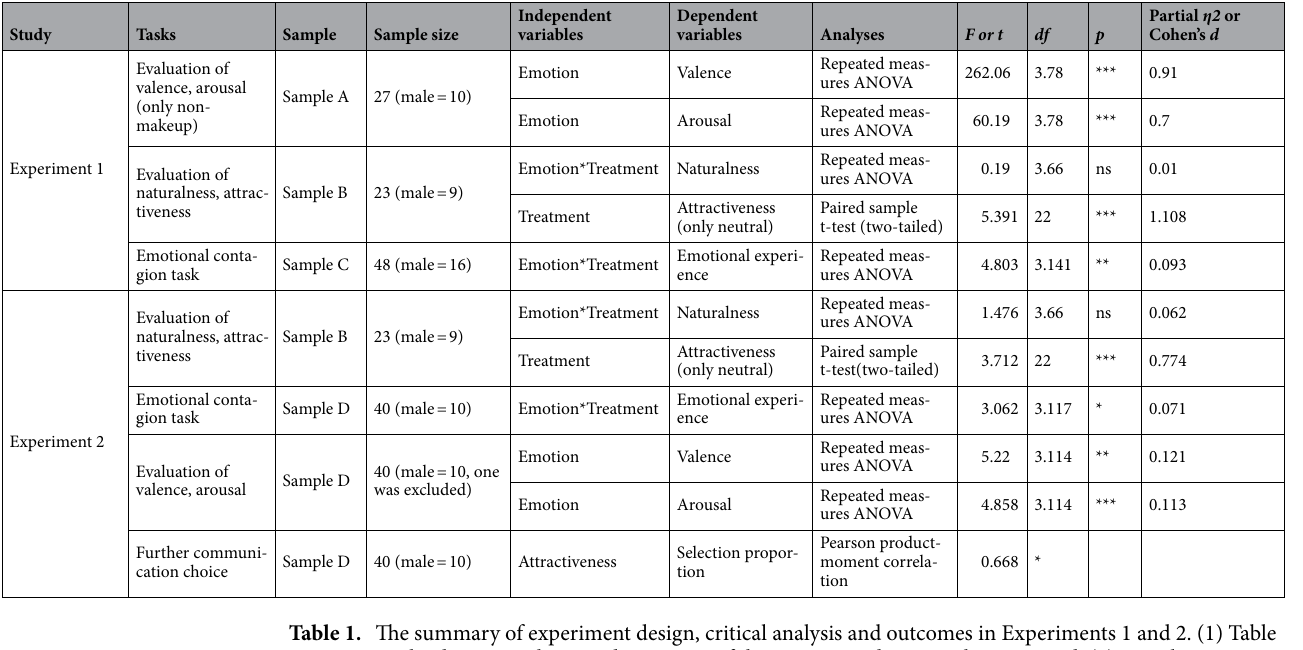
Table 1. The summary of experiment design, critical analysis and outcomes in Experiments 1 and 2. (1) Table summarizes the design, analysis, and outcomes of the current study is mainly concerned. (2) Samples A, B, C, and D were used to represent different sources of participants. (3) Samples A and B were mainly recruited to complete the experiments on the operational validity test, including the evaluation of attractiveness, naturalness, and emotional attributes (valence and arousal), except for the evaluation of emotional attributes in Experiment 2; Samples C and D were recruited to accomplish the formal experiments (emotional contagion task). (4) To ensure that the manipulation of emotional materials was effective, Sample A was employed to evaluate the emotional valence and arousal before Experiment 1. Meanwhile, given that the evaluation of material naturalness and attractiveness may lead participants to guess the purpose of the emotional contagion task or pay too much attention to whether the emotional expression is natural, Sample B was recruited to evaluate the naturalness and attractiveness of the materials in Experiment 1. Moreover, to ensure evaluation consistency of naturalness and attractiveness between the two experiments, Sample B was also recruited in Experiment 2. Furthermore, in Experiment 2, we used Sample D for emotional contagion, emotional valence, and arousal, considering the need to calculate the correlation between the two. (5) “*”means p < 0.05,